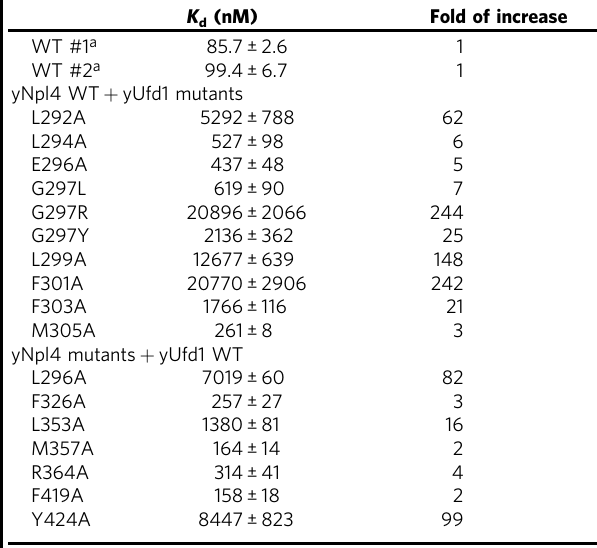
Table 3 Binding af fi nity of yNpl4 for